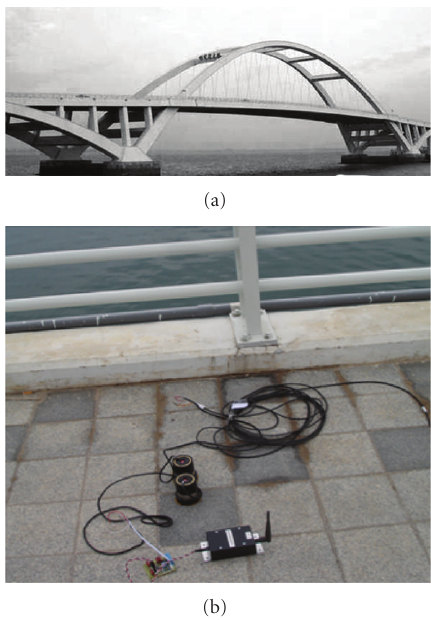
Figure 5: (a) Side view of the Wuyuan Bridge; (b) wireless sensing node on the